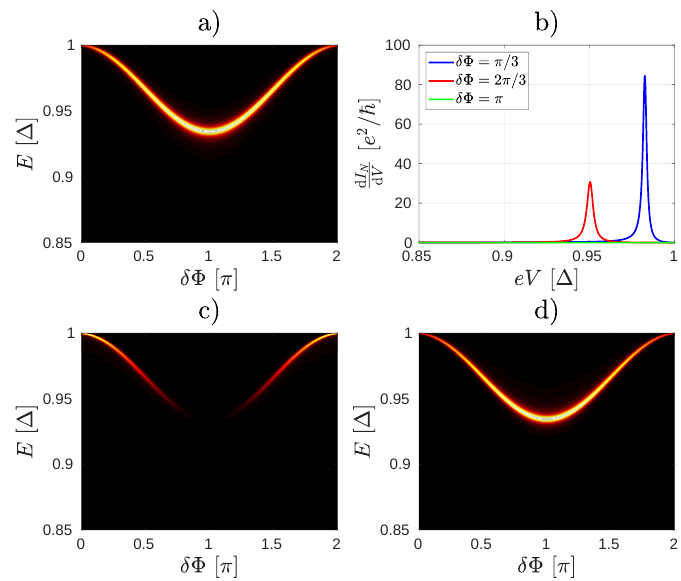
Figure 8. ( a ) The density of states of the ABS for the case shown in Figure 6c. ( b ) The differential conductance corresponding to ( a ). The local density of states for electron ( c ) and hole ( d ) quasiparticles as a function of δ Φ . In these calculations we used ε 3 = − 0.50 γ 0